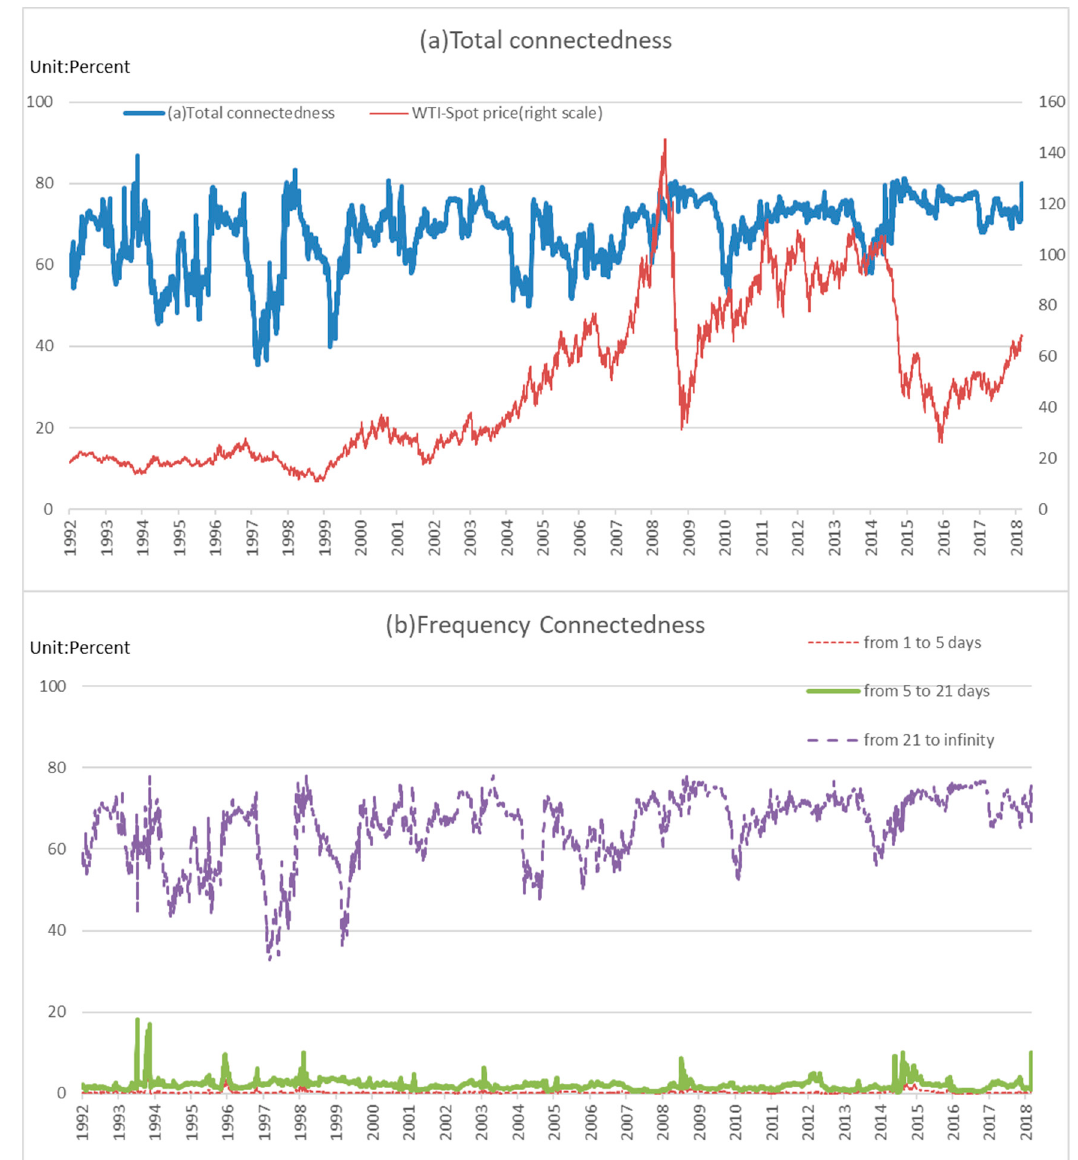
Figure 3. Dynamic frequency connectedness for volatilities.